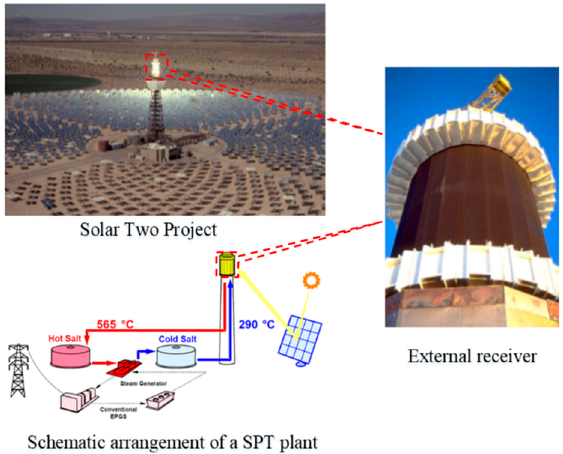
Figure 1. Schematic view and pictures of the SPT demonstration facility Solar Two [3].